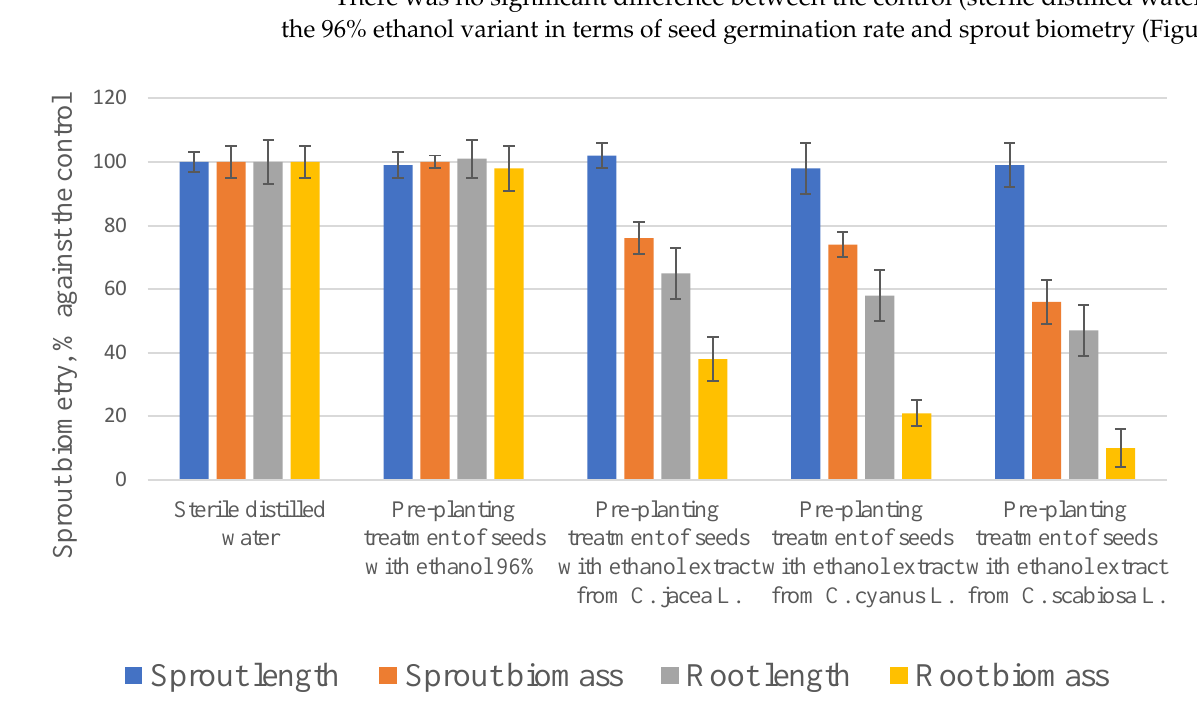
Table 7. Quantification of flavonoids and their total content in the flowers of 3 Centaurea species extracted by 70% ethanol. Species Rutin, mg/L Centaurea cyanus L. Centaurea jacea L. Centaurea scabiosa L.